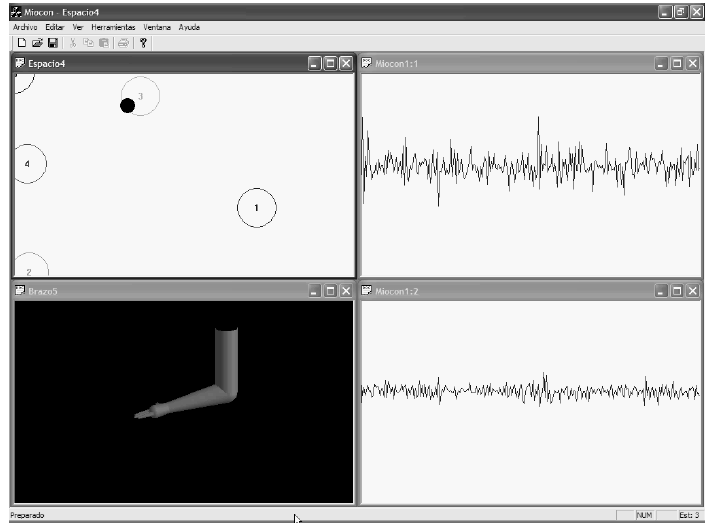
Figure 17. Medium biceps activity and low triceps activity. EMGs from biceps and triceps are shown at the top and bottom graphs respectively. At this moment, pointer in the state navigator is over state #3. State #3 is assigned to hand opening.